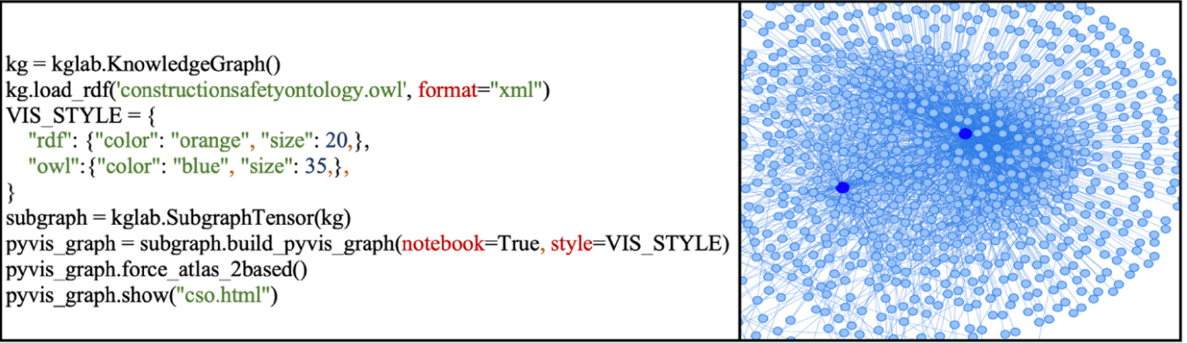
Figure 11 . Graph-based visualization of accident data .